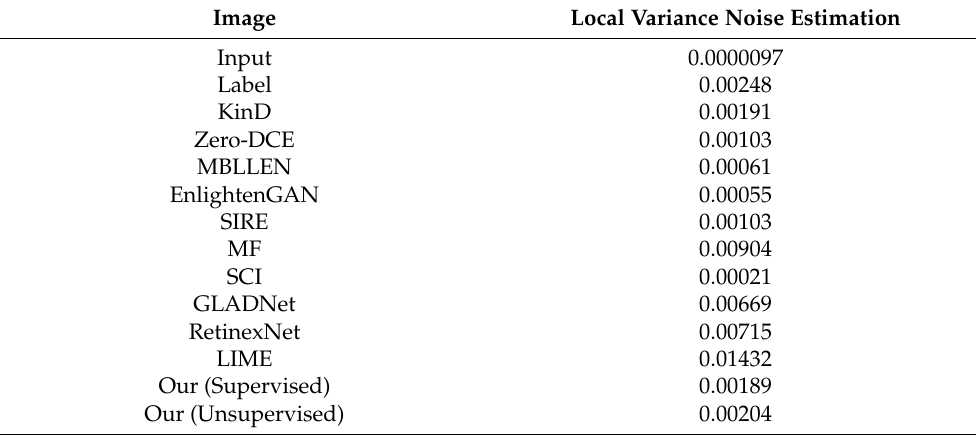
Table 4. Comparison of Image Noise Level of Different